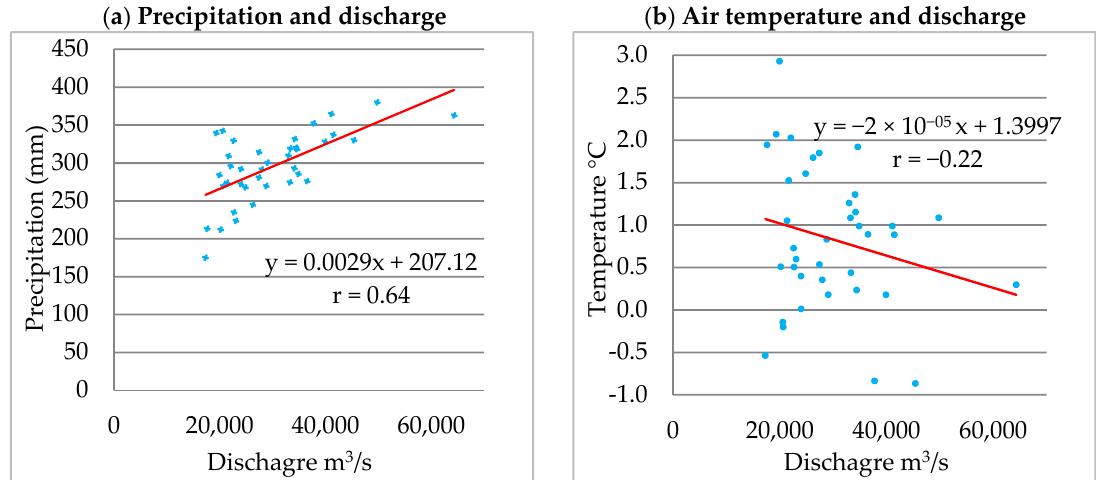
Figure 9. Correlation coefficient: climate and river discharge.